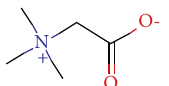
Figure 1: Chemical structure of